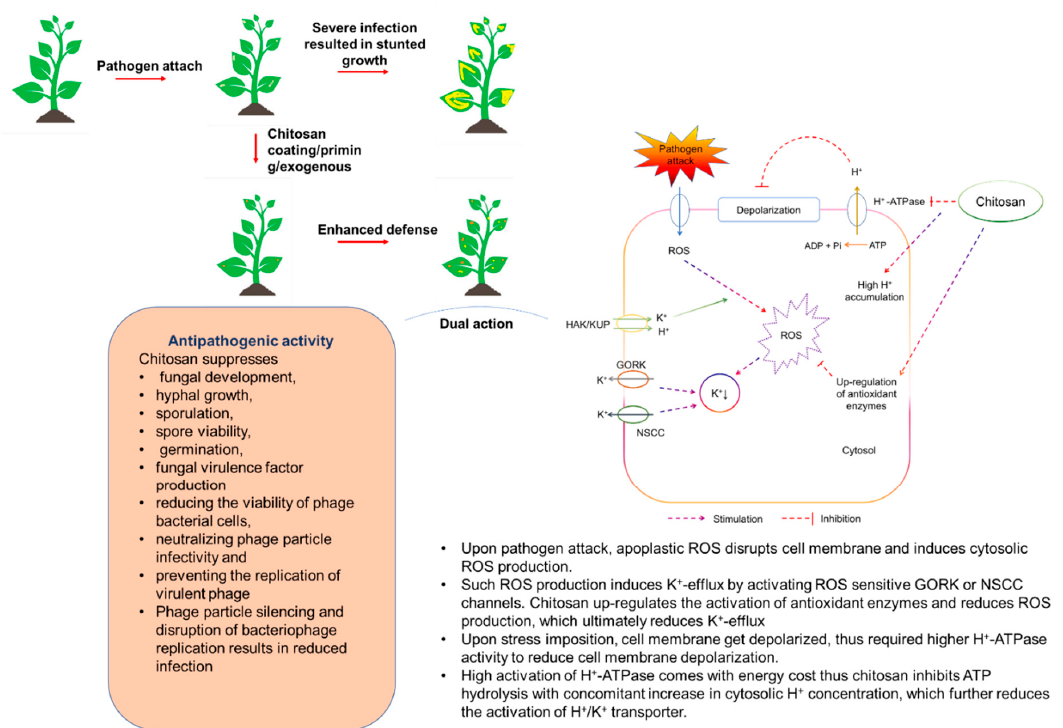
Figure 2. An overview of chitosan-mediated disease suppression in plants.